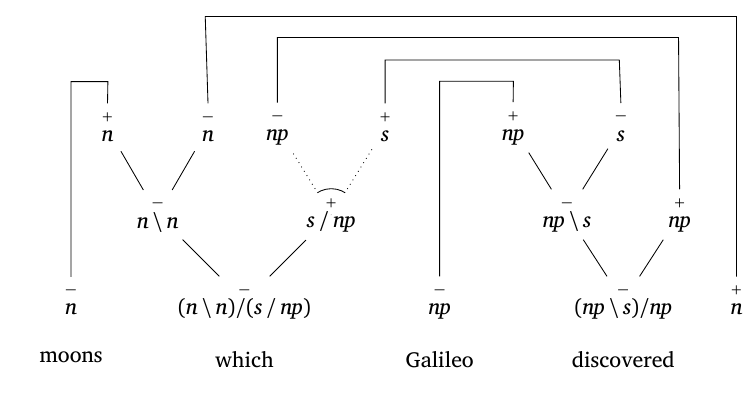
Figure 4: Proof net for “moons which